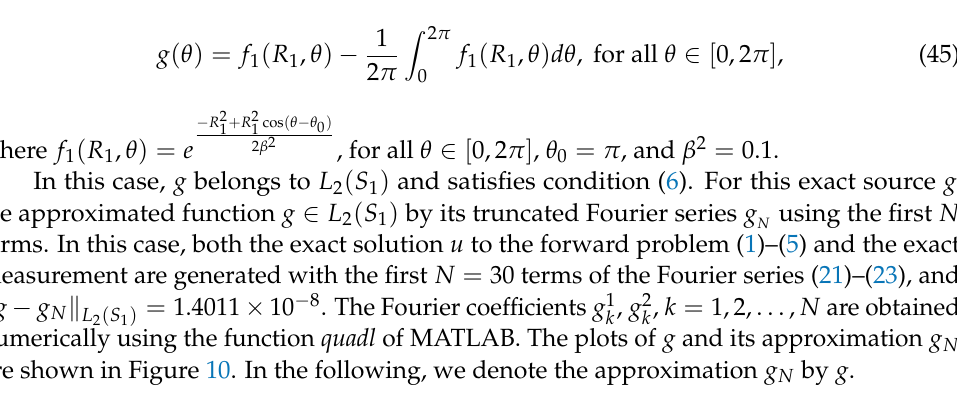
Table 5. Numerical results applying methods 1 and 2 for circular region with noisy data V δ for δ = 0.1, using the mesh M 1 ( 774, 1470 ) , and with the same measurement with error V δ for each source. NA means not applicable. Method